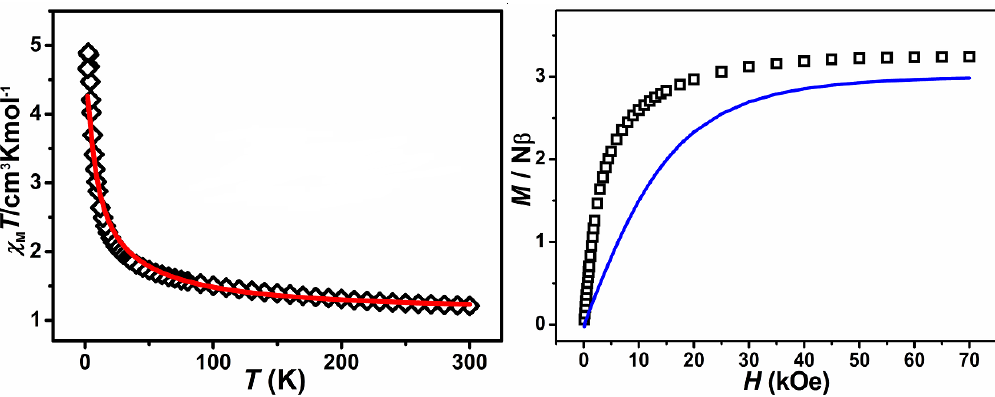
Figure 6. ( left ) χ M T versus T chart of the reticular complex in 2 (the crimson curve denotes the fitting result). ( right ) M versus H chart at 2 K (the blue curve denotes the sum of the Brillouin function).